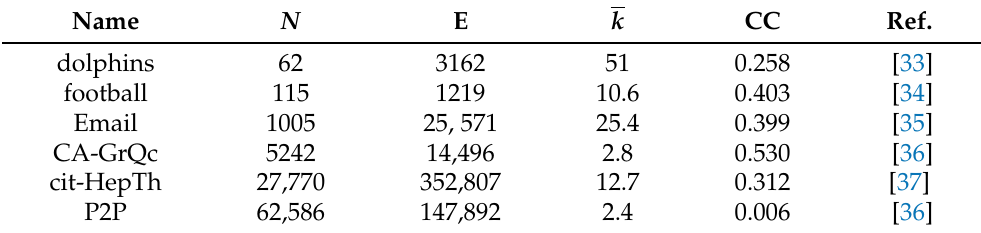
Table 2. The basic features of real-world networks in the experiments are shown in the Table 2, in- cluding the number of nodes and edges, average degree, average clustering coefficient and